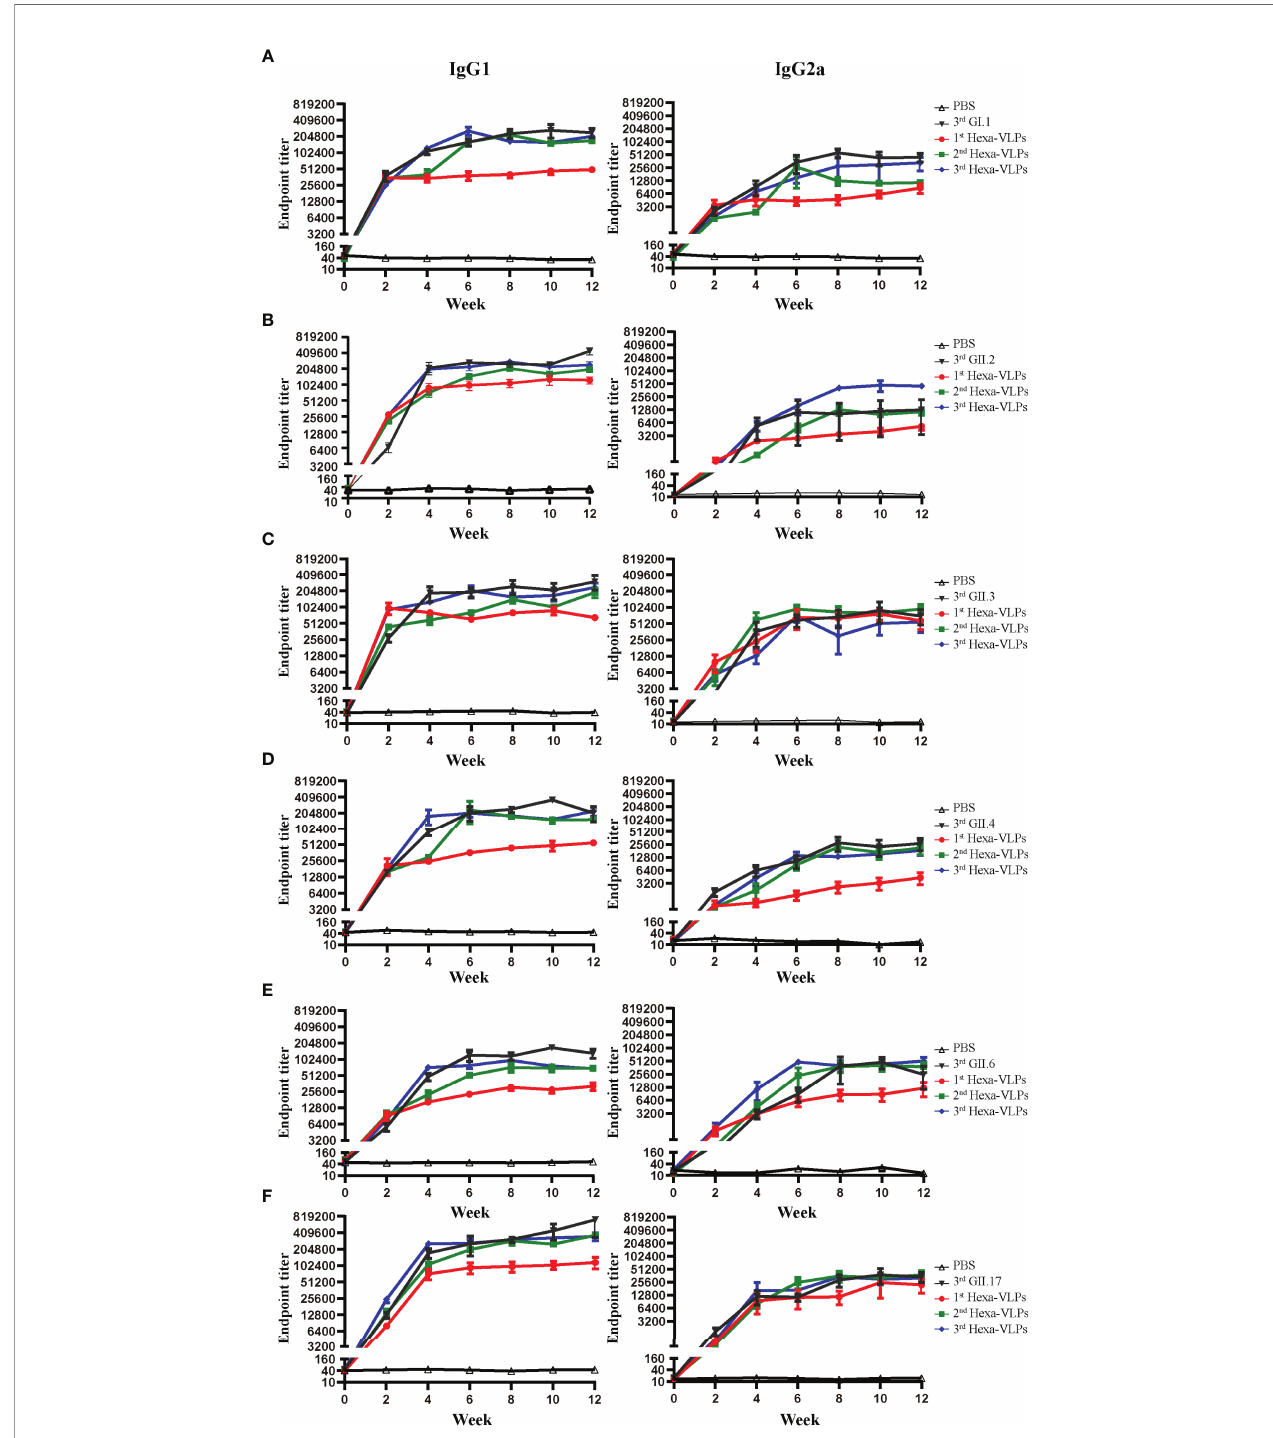
FIGURE 6 | IgG subclass antibody detection of different immune regimens. Isotype pro fi les were determined with direct ELISA using plates coated with the puri fi ed (A) GI.1, (B) GII.2, (C) GII.3, (D) GII.4, (E) GII.6 and (F) GII.17 VLPs. Each column from left to right represents endpoint titers of IgG1, IgG2a, respectively. Sera were 2-fold diluted with an initial dilution of 500-fold, endpoint titers of individual serum were determined as the reciprocal of the highest serum dilution giving an OD450 above the cut-off value. All data were shown as means ± SEM. Statistical differences at 4 w, 8 w, 12 w were analyzed using one-way ANOVA test with Tukey correction for multiple